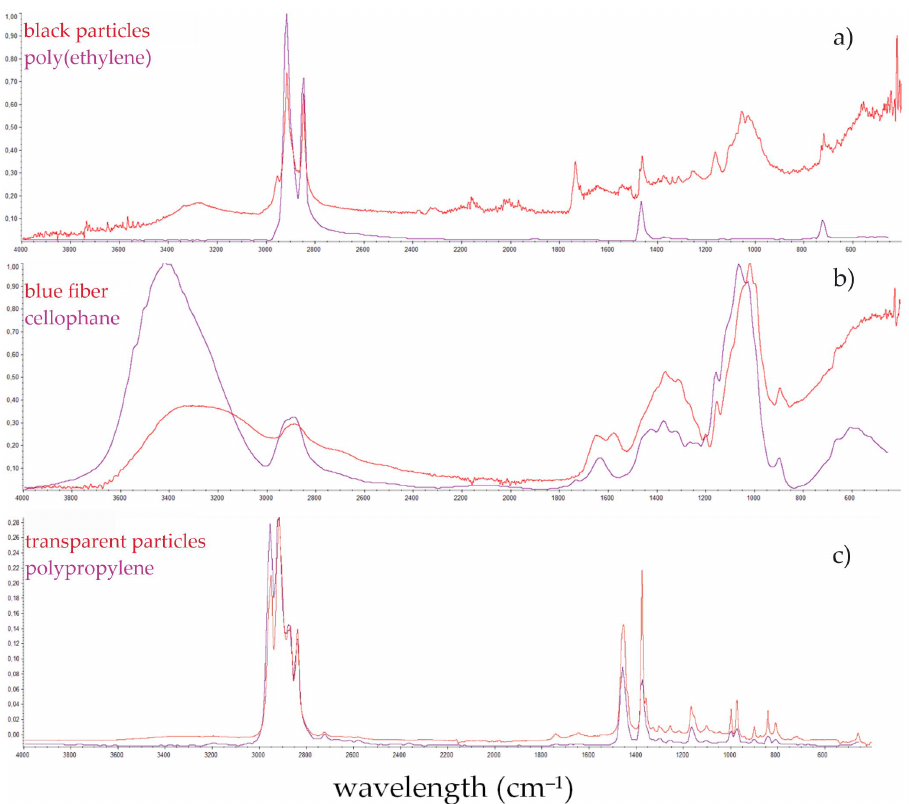
Figure 7. Sample spectra of identified polymers in fish: ( a ) polyethylene, ( b ) cellophane, ( c ) poly- propylene.